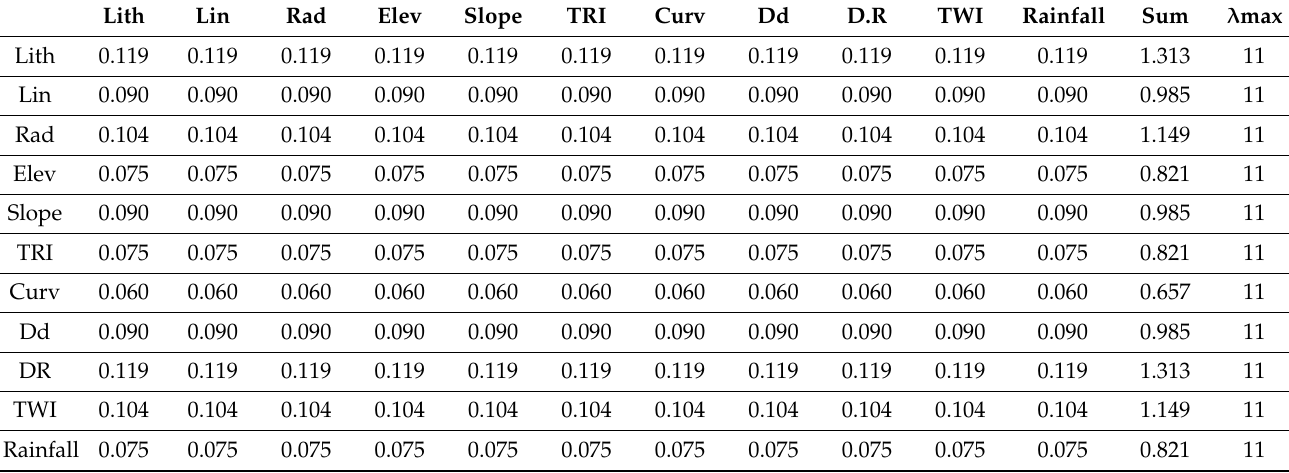
Table 3. Computing consistency